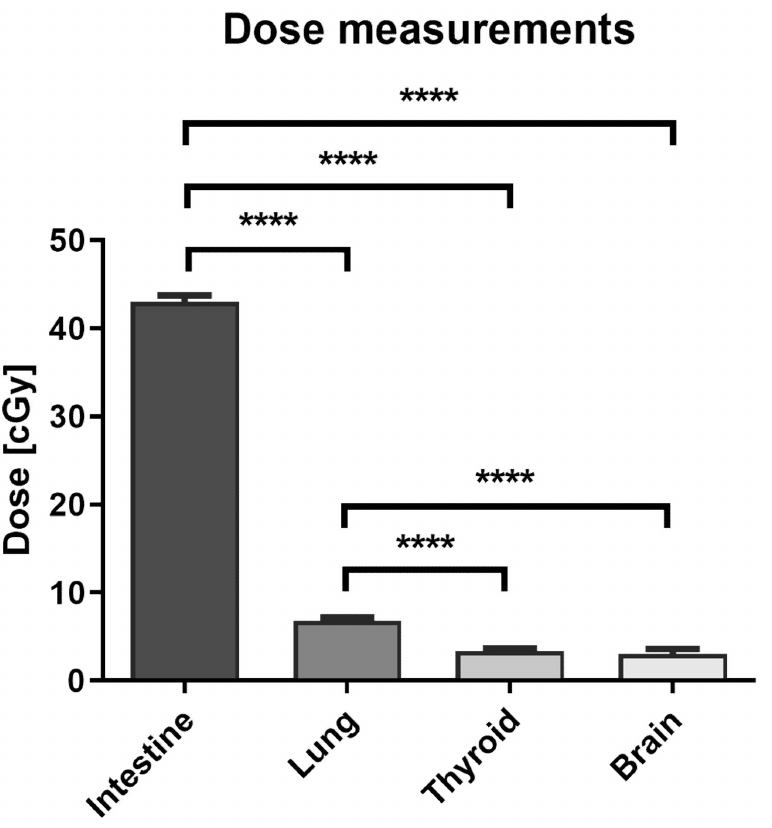
Figure 2. Radiation doses measured in peripheral organ locations following VMAT SBRT. Doses were measured using EBT3 Gafchromic films placed under culture flasks during irradiation. Data are shown as means ± SD for six independent experiments. ****— p < 0.0001, based on one-way ANOVA with Tukey’s post-hoc